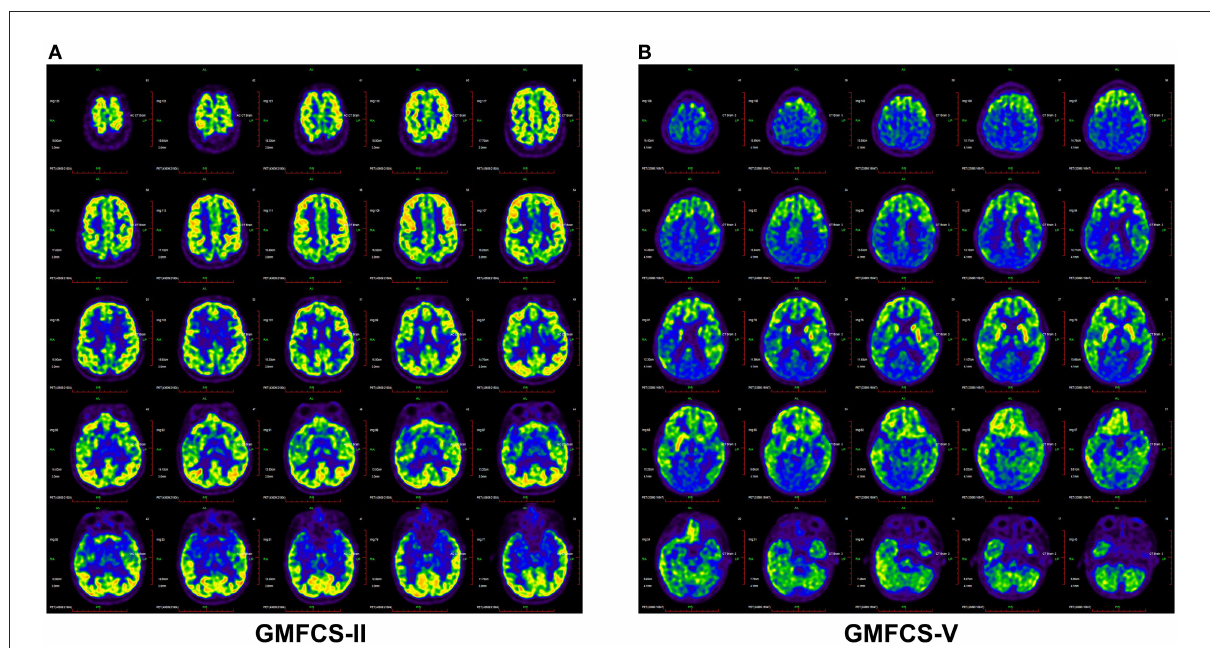
FIGURE2 Brain 18 F-FDG PET images demonstrated different metabolic activity of CP patients with GMFC level II (A) and V (B) . The CP patients with GMFC level V exhibited decreased activity compared with GMFC level